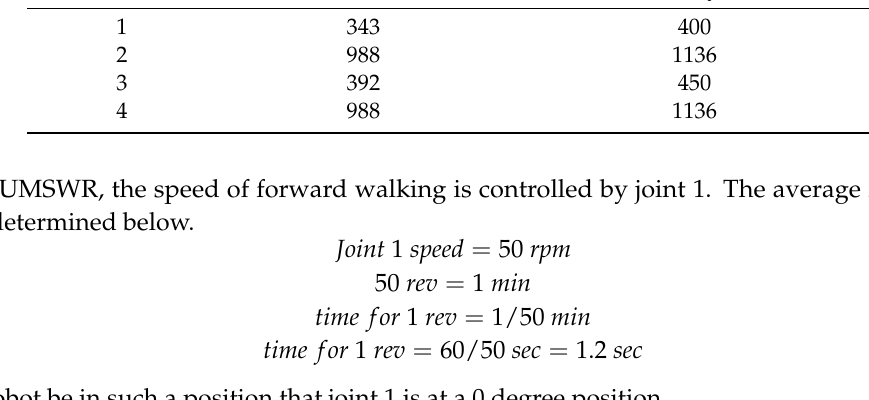
Figure 15. ( a ) Extreme load at joint 1 and ( b ) extreme load at joint 3.